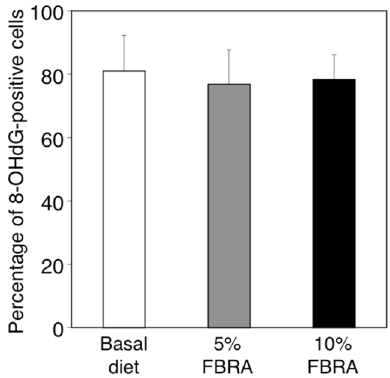
Figure 4. No difference was found between basal and FBRA ‐ containing diets in 8 ‐ OHdG formation in the tissues inflamed by co ‐ implantation of gelatin sponge with QR ‐ 32 cells. Bar graphs show means means ˘ SD ( n = 3 in each ± SD ( n = 3 in each group).